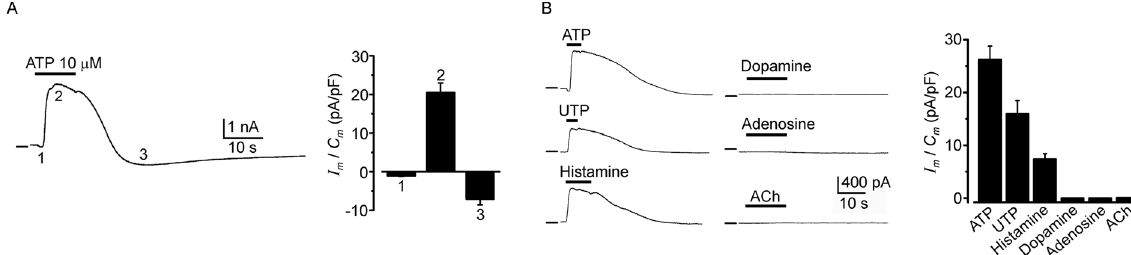
Figure 1. SKOV-3 cells respond to ATP by generating multiphasic ionic currents. ( A ) The trace shows a typical electrical response generated in SKOV-3 cells by ATP application; in cells held at − 40 mV, three main components are identified in the response: 1) a fast inward current with low amplitude, 2) a robust outward current, and 3) a slow inward current. All response components were associated with an increase in membrane conductance. The bar graph shows the current density recorded for each component in a sample of 39 cells. ( B ) Traces show that component 2 was also activated by UTP or histamine application. All agonists were applied at 10 µ M, and the bar graph summarizes the outward current density recorded in 60 cells tested for the various agonists. In general, in this and subsequent traces, responses were obtained in cells held at − 40 mV, and upper bars indicate the drug application time in each case. Horizontal lines indicate zero